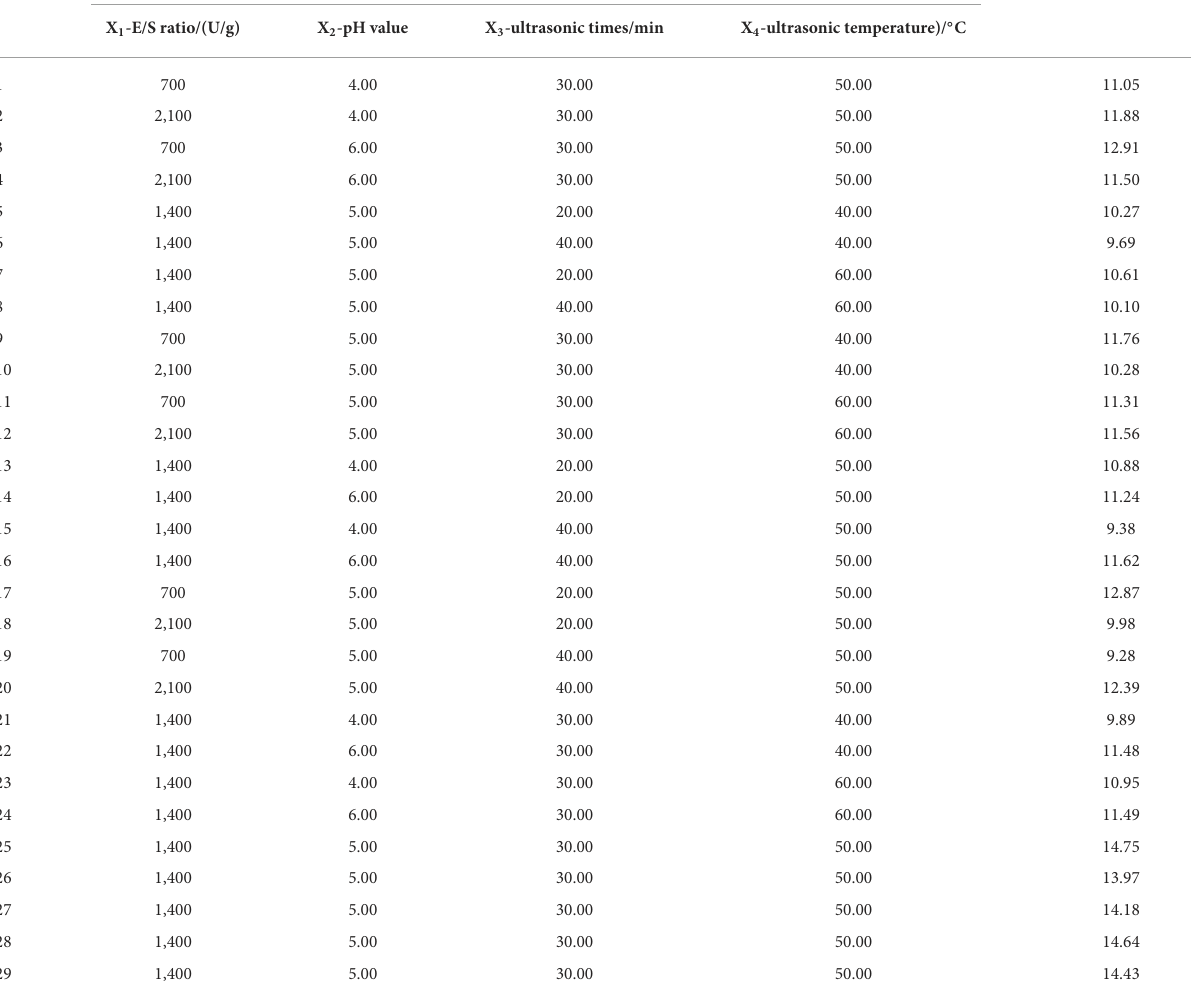
TABLE 2 Box-Benkhen design of the independent variables and experimental values of LLPs yield (Y). No.